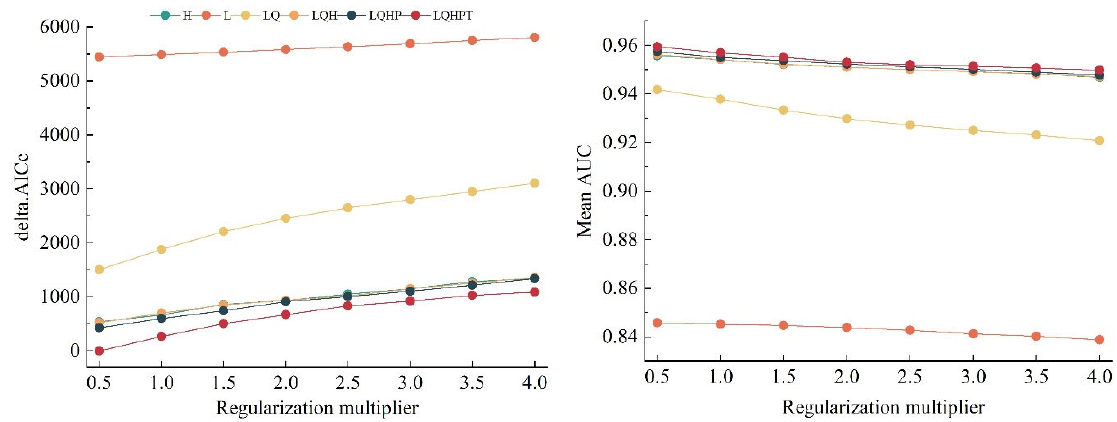
Figure 2. Optimal parameter results for the MaxEnt model.